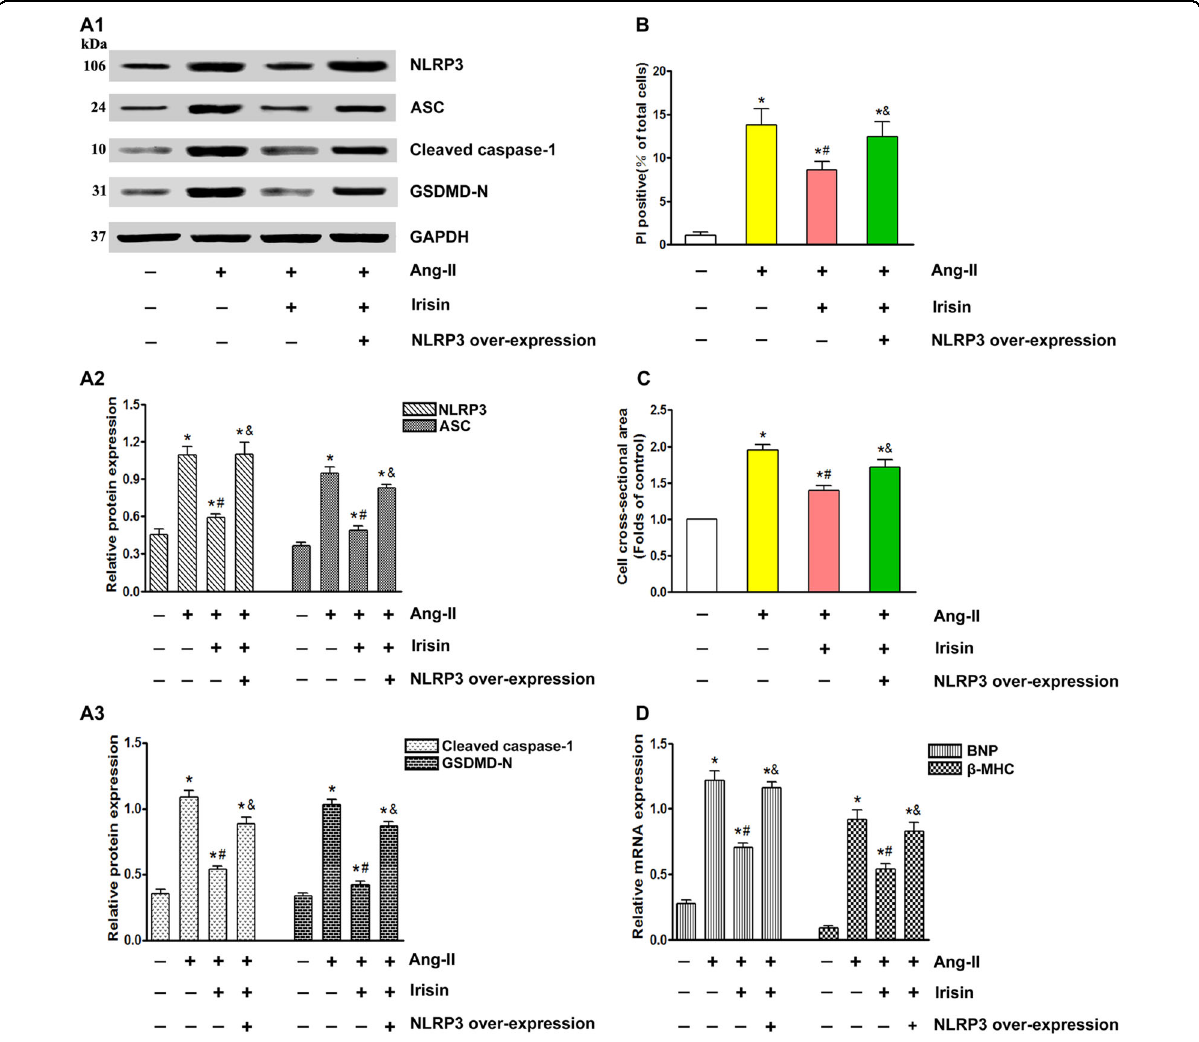
Fig. 6 Overexpression of NLRP3 reversed irisin-mediated antipyroptosis and anticardiac hypertrophy effects. A Immunoblots showing protein levels of NLRP3 and ASC ( A1 , A2 ), cleaved caspase-1, and GSDMD-N ( A1 , A3 ) in the suitably treated cardiomyocytes. B Percentage of PI- positive cells in the suitably treated cardiomyocytes. C Measurement of the cell surface area of cardiomyocytes in the indicated groups. D mRNA expression of cardiac hypertrophy markers BNP and β -MHC in the suitably treated cardiomyocytes. Results are presented as the mean ± SEM, n = 6. ∗ P < 0.01 compared to control, # P < 0.01 compared to Ang-II group, & P < 0.01 versus Ang-II + Irisin